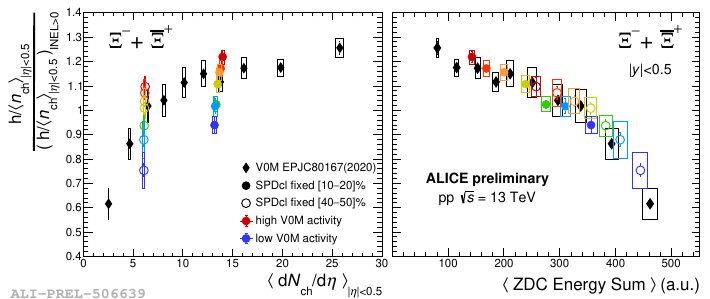
Figure 1. Ξ yield per charged particle self-normalized to INEL > 0 as a function of multiplicity at midrapidity on the left, and of the ZDC energy sum on the right. The black diamonds correspond to the analysis performed in V0M classes alone [7]; the colored full (open) squares present the double di ff erential analysis with SPDCluster fixed in [10 , 20]% ([40 , 50]%).